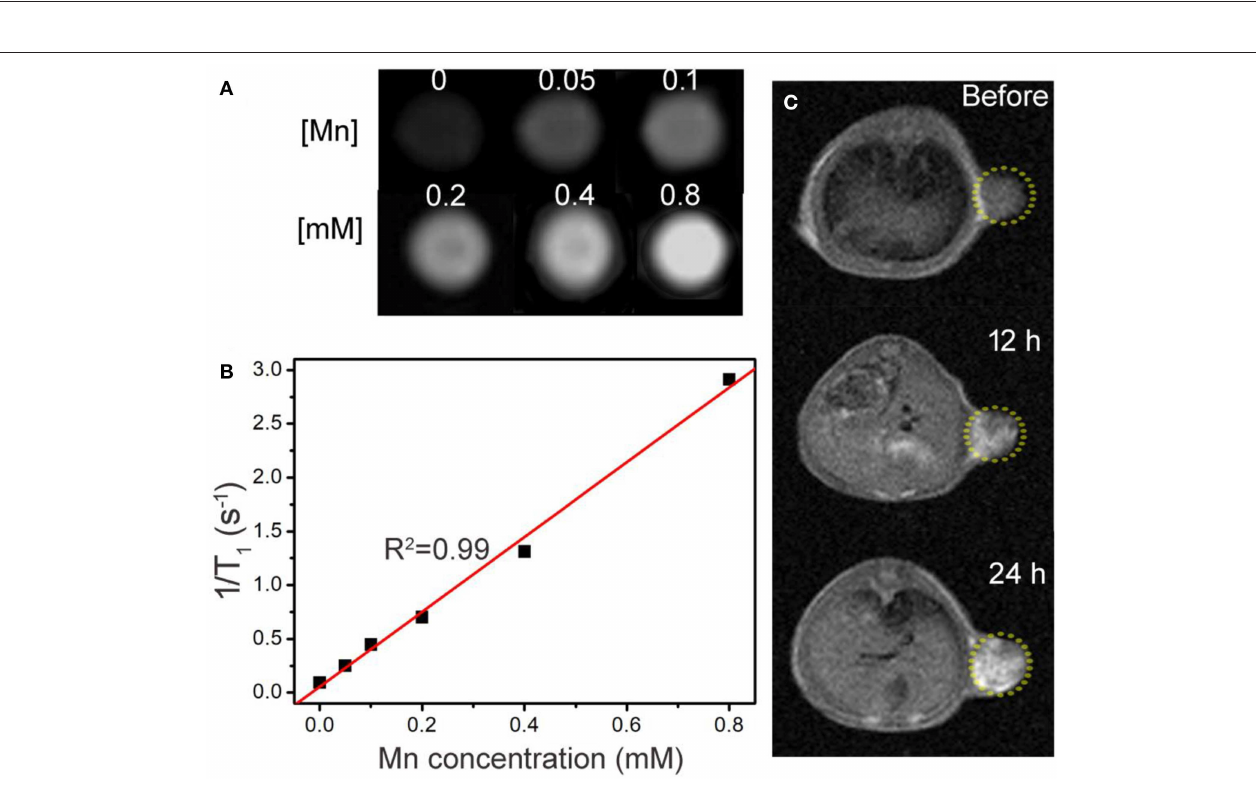
FIGURE 4 | (A) Phantom images of the CMO NCs. (B) Proton T 1 relaxation measurements at varied Mn concentrations (C) T 1 -weighted MR imaging in vivo of a tumor-bearing mouse before and after intravenous injection of a solution of CMO NCs. The position of the tumor is marked by yellow dotted circles.